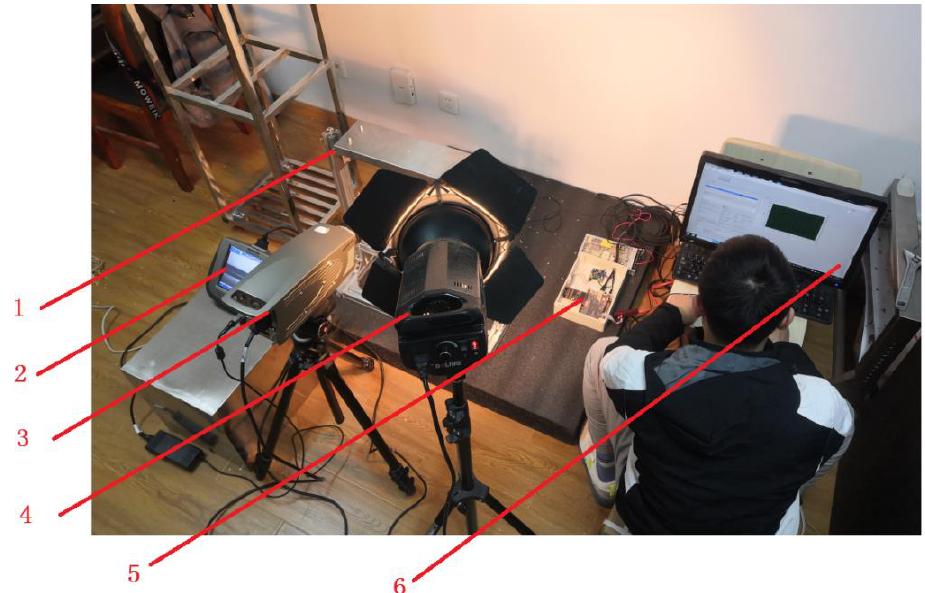
Figure 2. Grain collision test platform and signal acquisition system. ( 1 ) Grain loss sensor; (2) high-speed photographic display screen; ( 3 ) high-speed camera; ( 4 ) fill-in light; ( 5 ) signal acquisition system; ( 6 )computer with software to receive the signal.